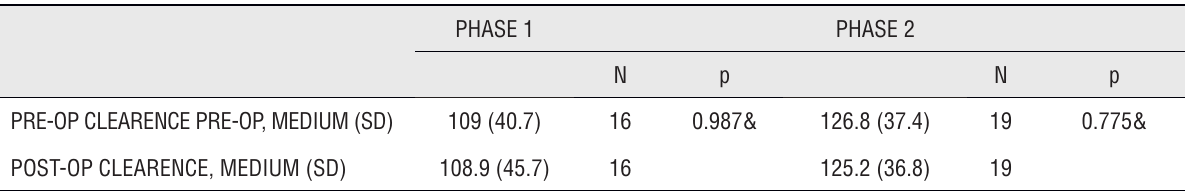
Table 2 - Paired analysis of clearance of